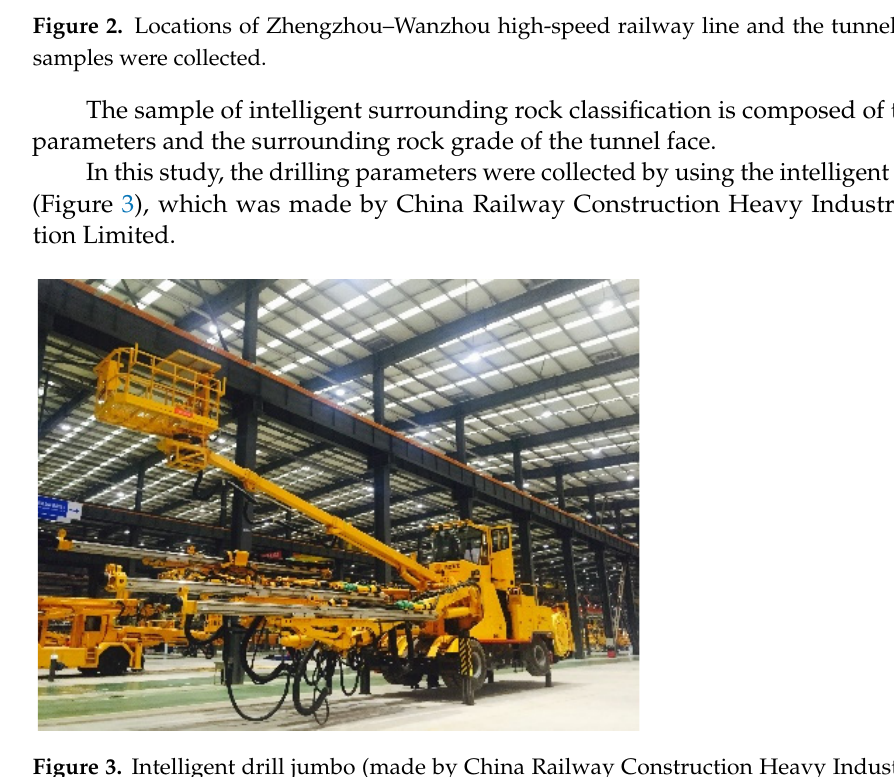
Figure 3. Intelligent drill jumbo (made by China Railway Construction Heavy Industry Corpora- tion Limited).